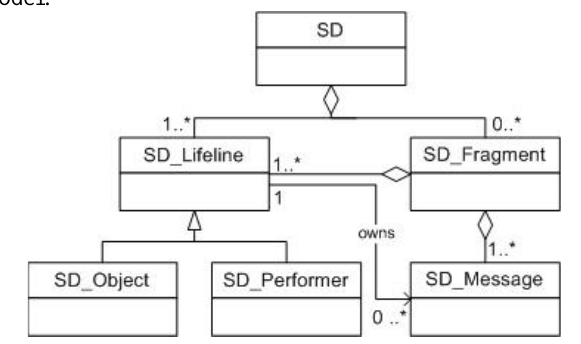
Fig. 2. Metamodel of the UML sequence diagram containing only transformable elements